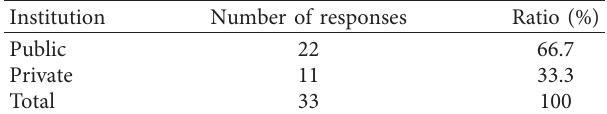
Table 5: Distribution of faculty responses by type of